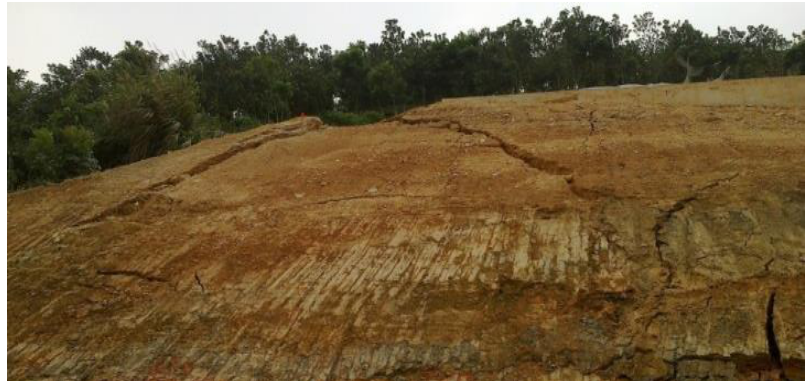
Figure 12. Landslide failure of a slope on expressway B, Guangdong, China.